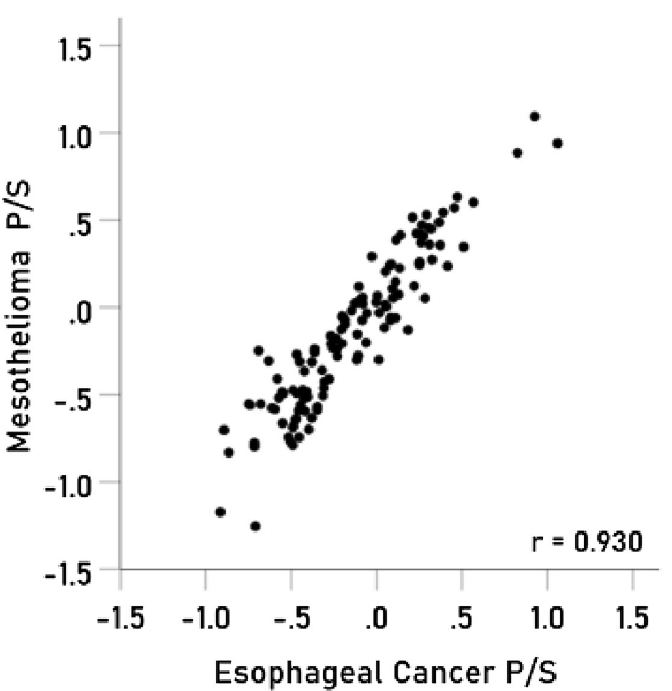
Figure 7. Immunogenetic P/S estimates for mesothelioma are plotted against those for esophageal cancer. P < 0.001; N =